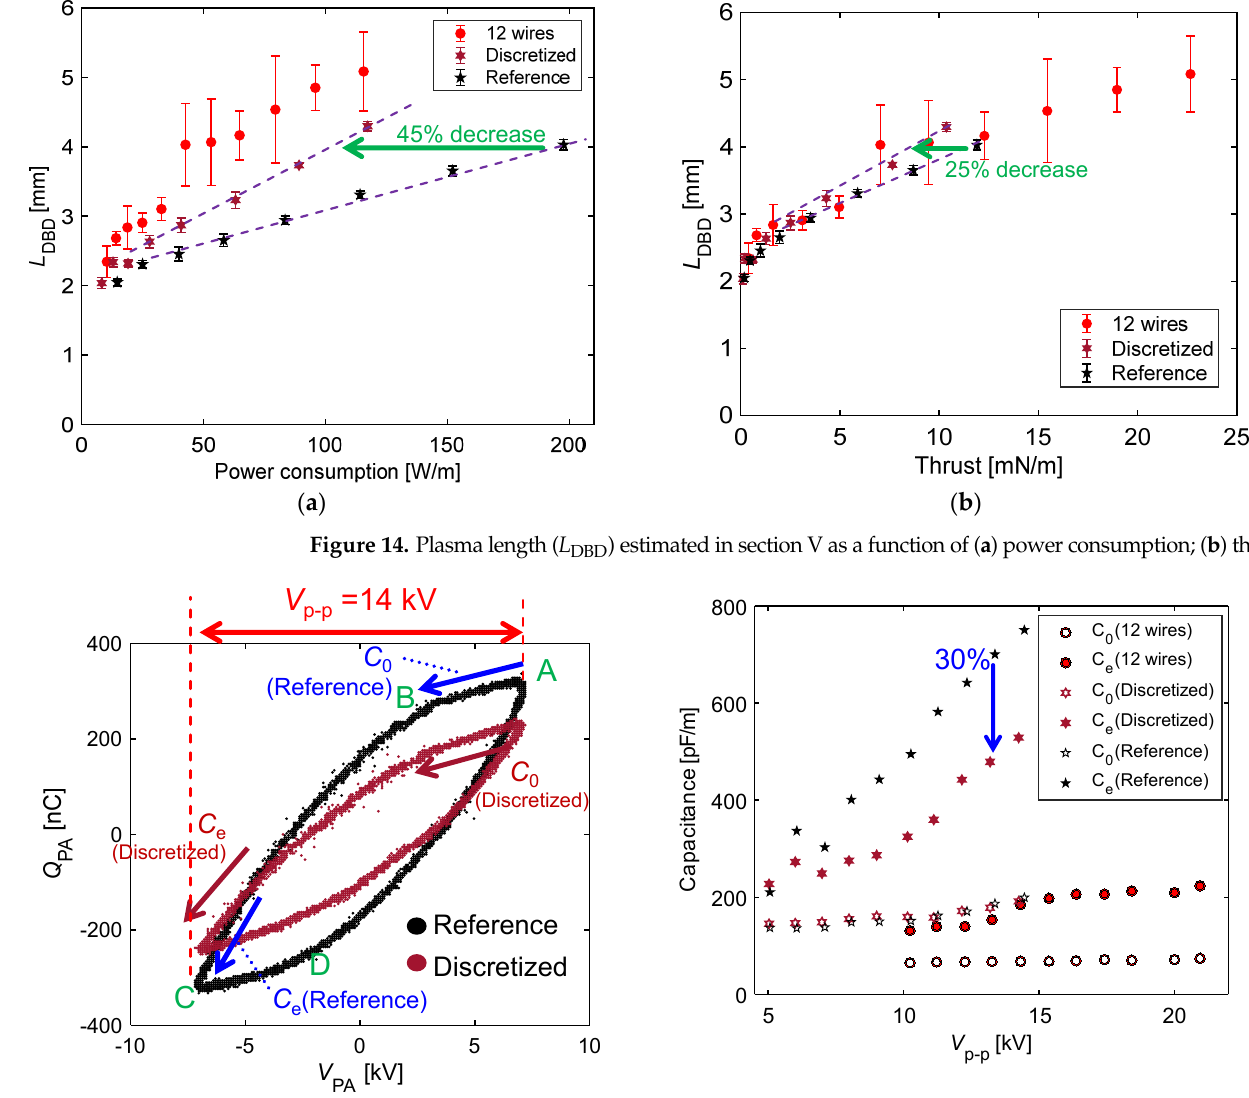
Figure 15. ( a ) Capacitance analysis of V – Q Lissajous figures under discharge and non-discharge periods (DBD: C e , non-DBD: C 0 ) of reference and discretized sheet-type PAs when V p-p = 14 kV; ( b ) variations in C e and C 0 as functions of V p-p for three types of PA.